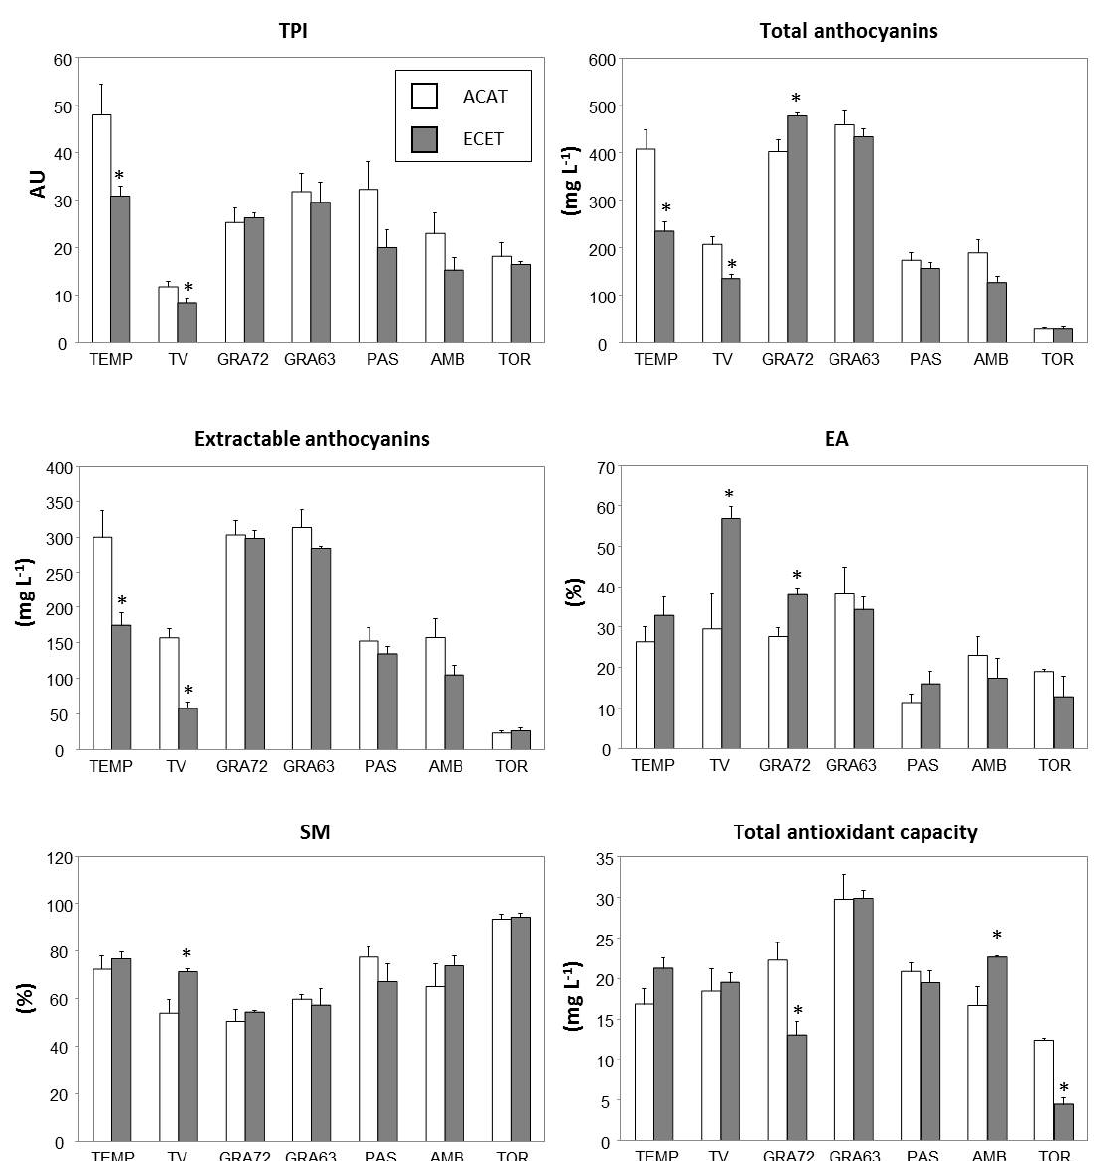
Figure 3. Phenolic composition and antioxidant capacity from fruit-bearing cuttings of genotypes from seven local old grapevine varieties recovered in Navarre (Spain) grown under two climate scenarios during berry ripening: (1) ambient CO 2 (400 ppm) and ambient temperature (T) (ACAT) and (2) elevated CO 2 (700 ppm) and elevated temperature (T + 4 °C) (ECET). Values are means ± S.E. (n = 3–6). Within each genotype, asterisks (*) indicate significant differences ( p < 0.05) between treatments according to Duncan’s test. Genotype labels can be found in Table 5.